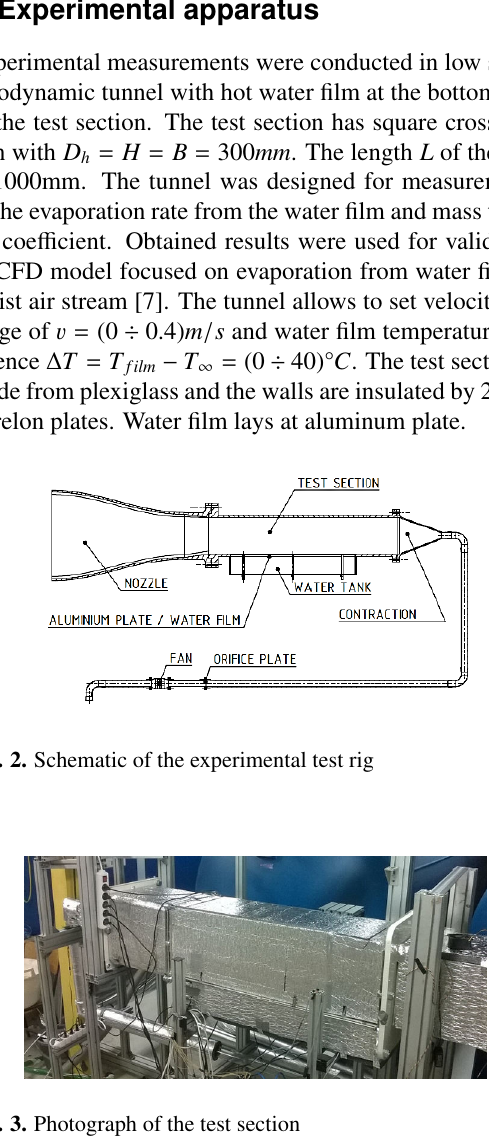
Fig. 3. Photograph of the test